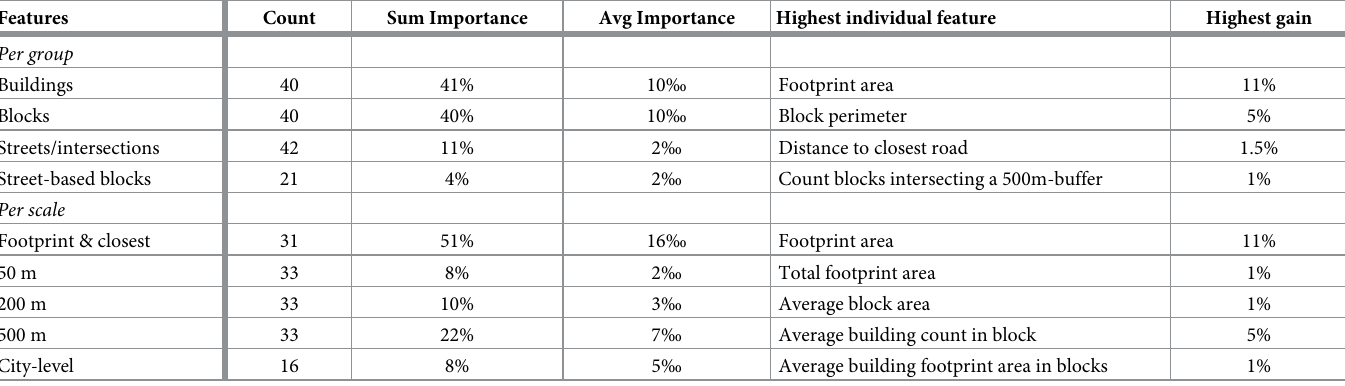
Table 5. Feature